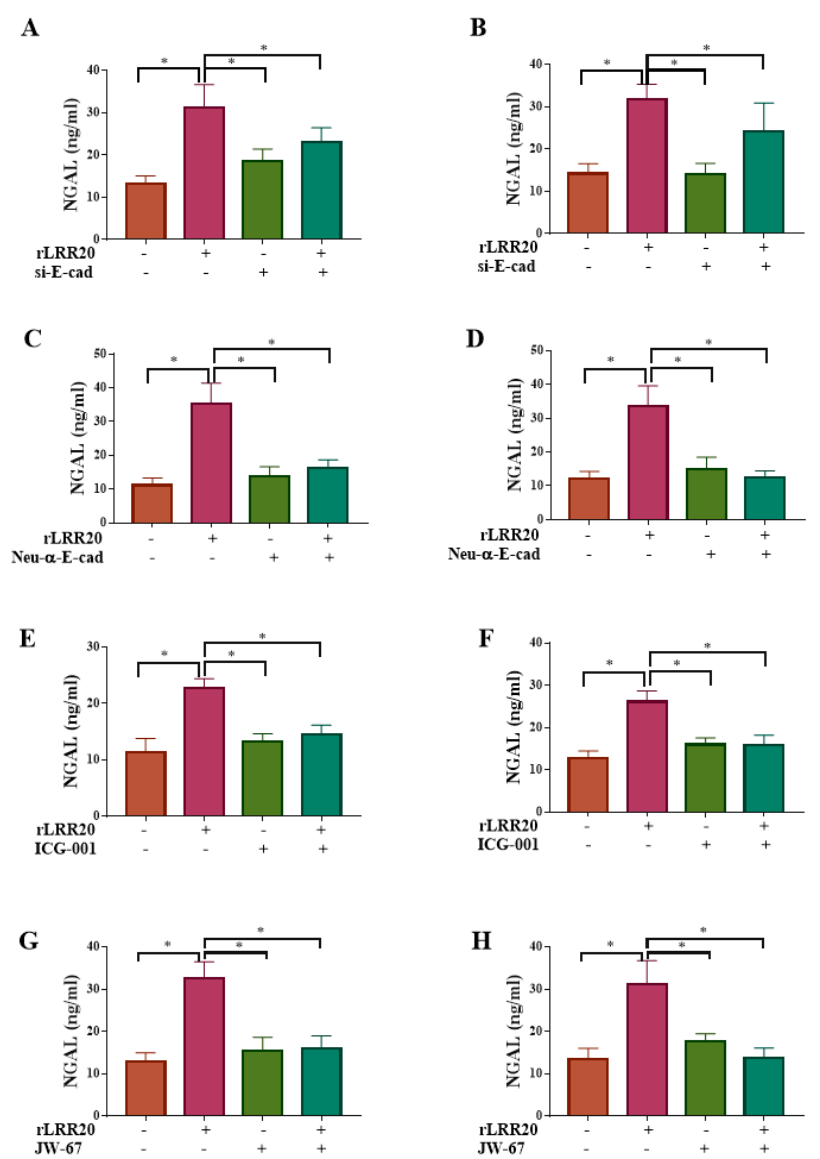
Figure 8. rLRR20 regulates NGAL expression through the E-cadherin/ β -catenin pathway. rLRR20- mediated regulation of NGAL expression through the E-cadherin/ β -catenin pathway was deter- mined using various inhibitors. Effect of short interfering RNA against E-cadherin (si-E-cad) on NGAL expression in HK2s ( A ) and hRPTECs ( B ). Effect of Neu- α -E-cad antibody on NGAL expres- sion in HK2s ( C ) and hRPTECs ( D ). Effect of ICG-001, a β -catenin inhibitor, on NGAL expression in HK2s ( E ) and hRPTECs ( F ). JW-67, a β -catenin inhibitor, on NGAL expression in HK2s ( G ) and hRPTECs ( H ). Dimethyl sulfoxide (DMSO) was used as the control. * p < 0.05.